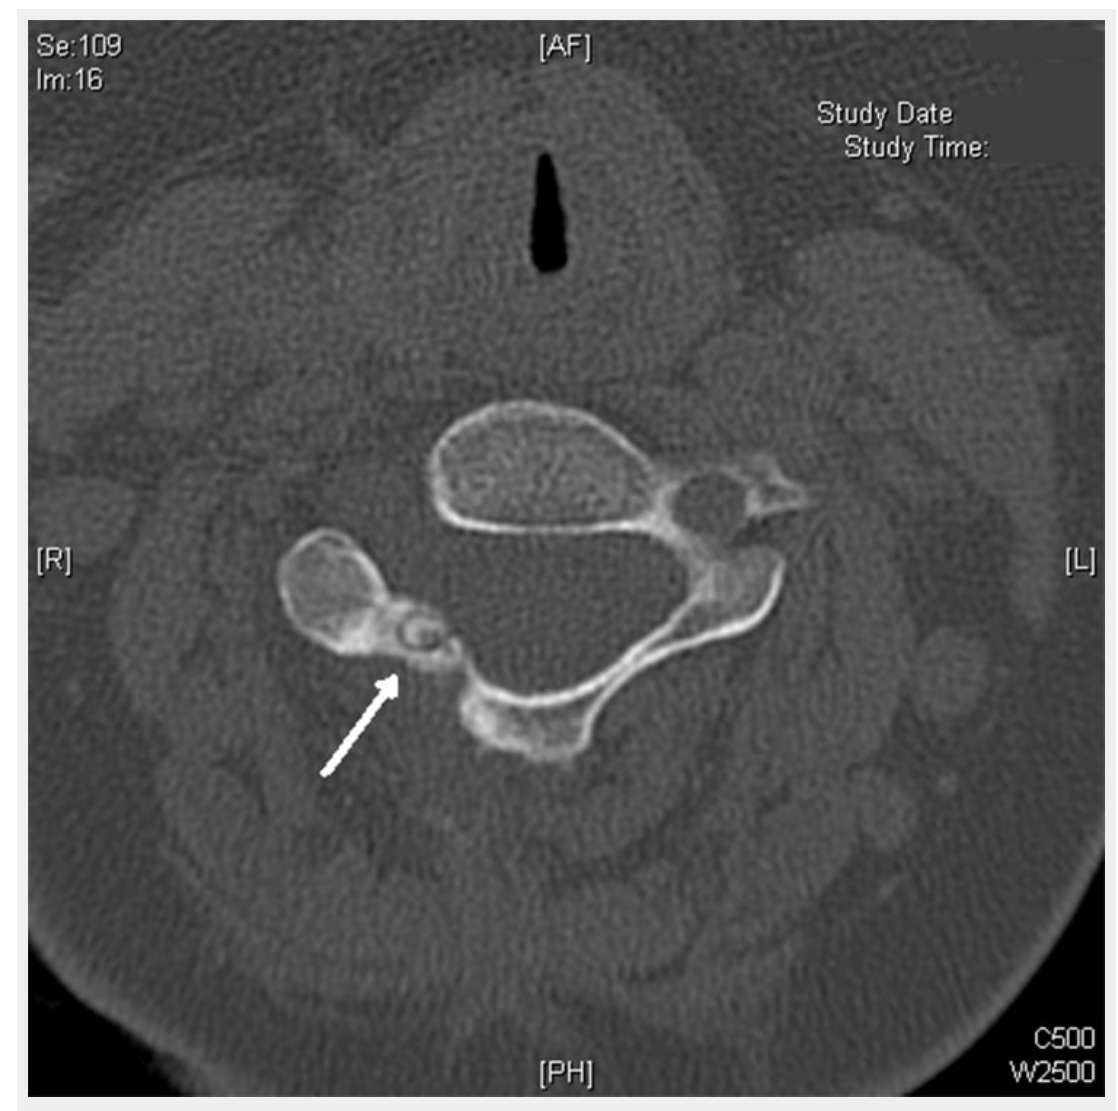
Figure 5 9-year-old boy with a several months long history of right arm and intermittent neck pain ‒ predominantly during the night ‒ which did not respond to physiotherapy. The initial radiograph was found to be normal. A CT scan ( A ) and a